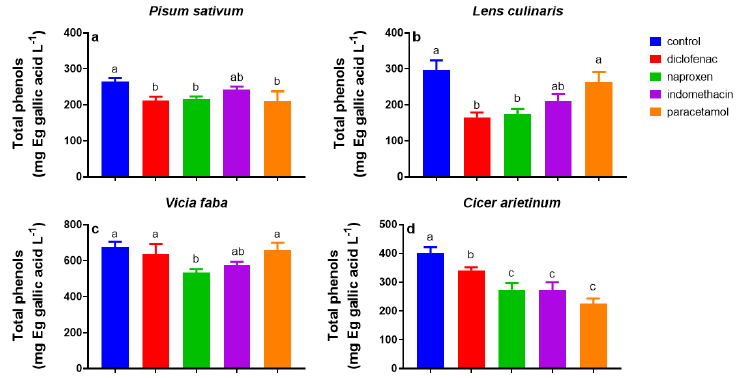
Figure 9. Total phenols concentration from Pisum sativum ( a ), Lens culinaris ( b ), Vicia faba ( c ), and Cicer arietinum ( d ). Plants in 0.5 L pots filled with commercial garden soil were treated by watering 100 mL of 0.5 mg L − 1 NSAIDs every second day over a total of 20 days. The values are averages of three independent measurements. Data sharing different letters are significantly different ( p < 0.05), while data sharing the same letters are not significantly different ( p > 0.05).